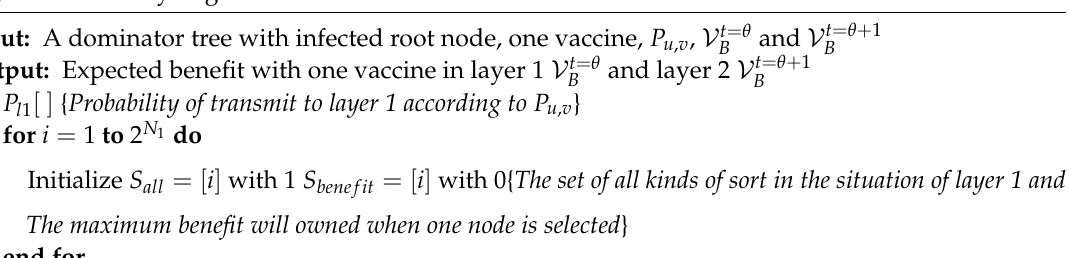
Algorithm 3 Analyzing the benefit of each time slot.